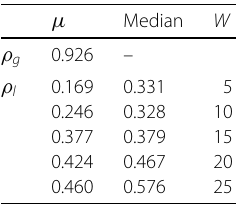
Table 1 Results of the global and local synchronicity of the two temporal series. The global synchronicity of the two series is extremely high, while the local synchronicity increases as we enlarge the temporal window